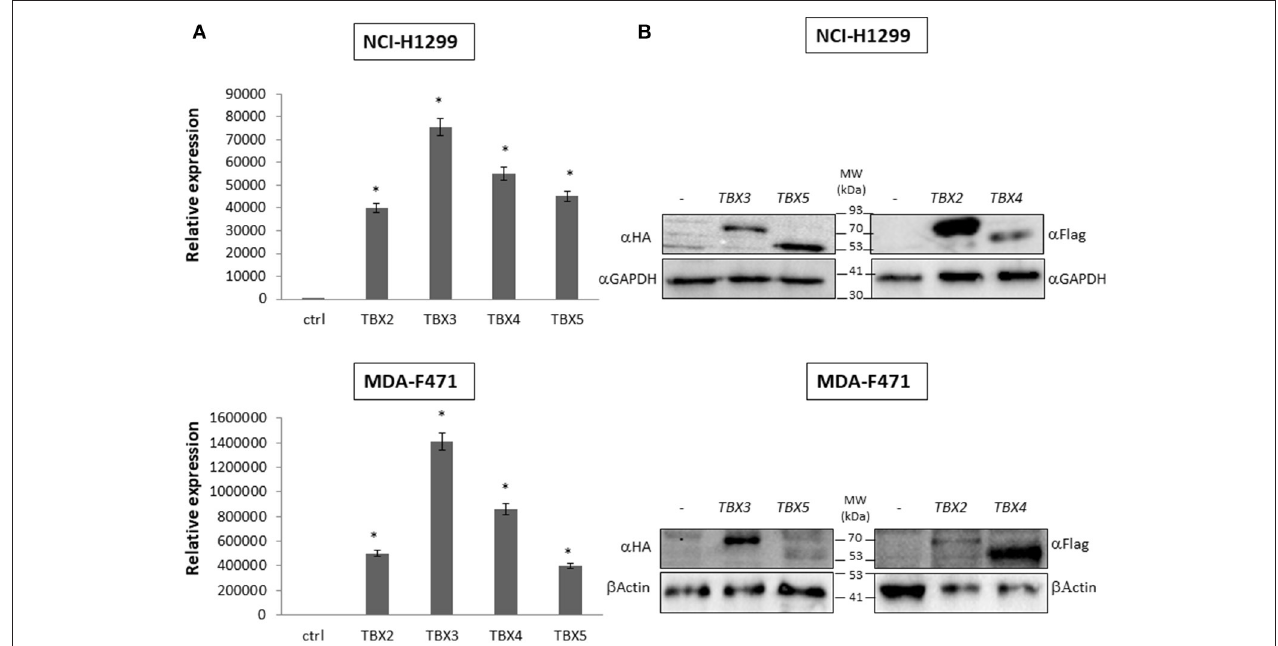
FIGURE 2 | Molecular analysis of NCI-H1299 and MDA-F471 cells transiently overexpressing the different TBX proteins. Western blotting analyses and qPCR of TBX2-5 protein and mRNA expression were performed 24h after transfection with the empty vector (–), or plasmids encoding the four members of TBX2 subfamily (A) For qPCR, TBXs’ expression was normalized to that of the GAPDH housekeeping gene and quantified relative to the expression in cells transfected with empty vector. The data represent the means ± s.d., n = 2. Significance (* p < 0.05) was assessed by the Student t -test (B) For Western blotting, 20 µ g of total protein from samples were analyzed by SDS-PAGE. Membranes were stained with the antibody against the corresponding tag of each vector and with a GAPDH or β -Actin antibody to ensure equal protein